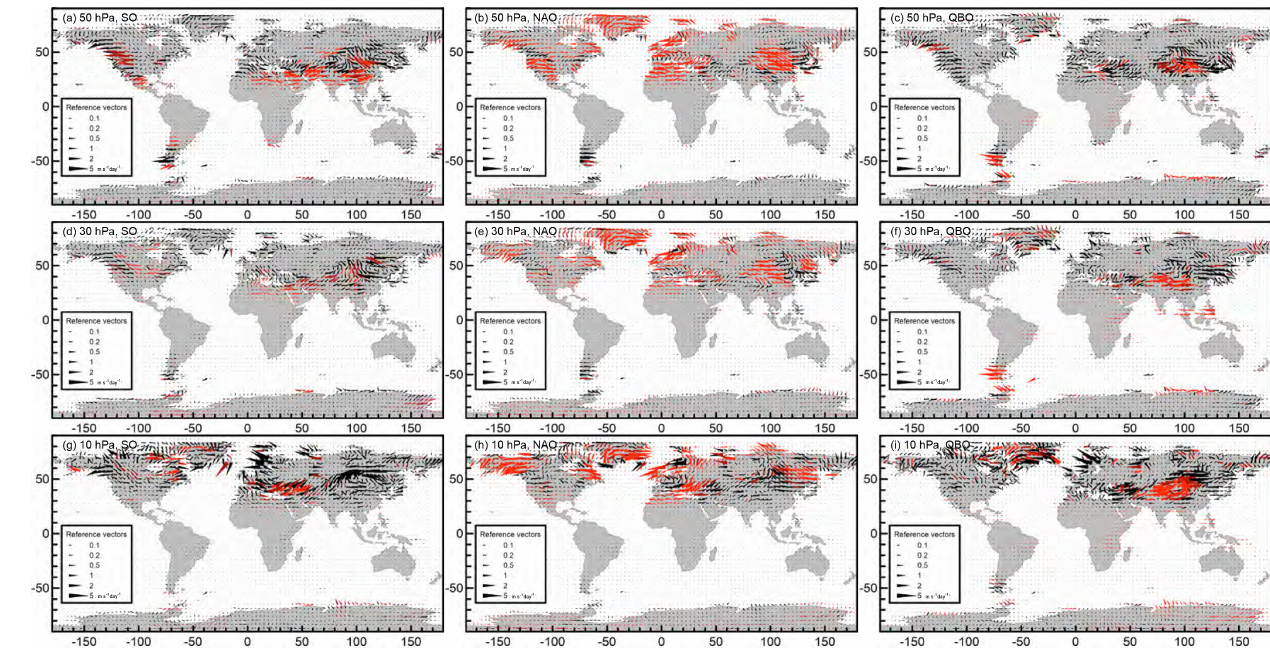
Figure 3. Response of the OGWD (ms − 1 day − 1 ) at the 50hPa (a, b, c) , 30hPa (d, e, f) and 10hPa (g, h, i) level related to the activity of the Southern Oscillation (a, d, g) , North Atlantic Oscillation (b, e, h) and quasi-biennial oscillation (c, f, i) . The responses correspond to the increase in the oscillation index by four times its SD, i.e., to the transition of the respective oscillation from a highly negative to a highly positive phase; red symbols pertain to locations with at least one wind tendency component response statistically significant at the 95% confidence level; bright red indicates at least one component significant at the 99% confidence level. Analysis period: 1979–2010, monthly data, DJF